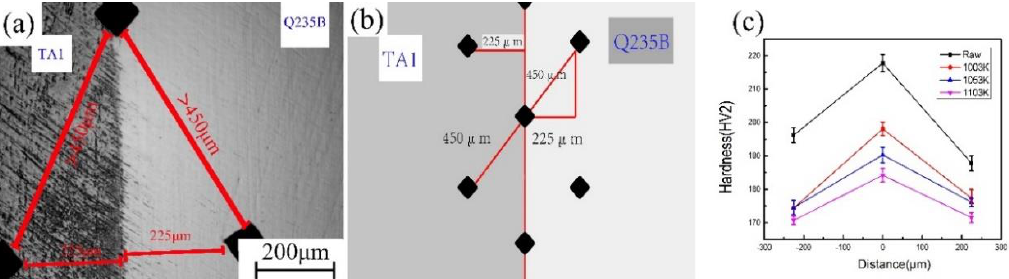
Figure 11. ( a ) Micrograph of microhardness test ( b ) schematic of microhardness test ( c ) microhardness of explosive welding plate and different temperatures rolled sheets.